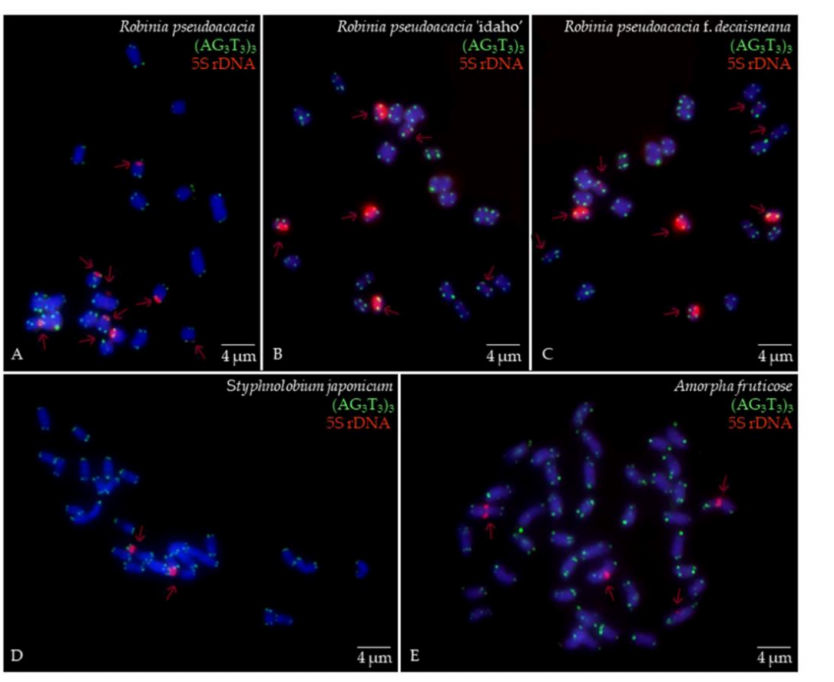
Figure 1. Mitotic metaphase chromosomes fluorescence in situ hybridization (FISH) visualization of R. pseudoacacia ( A ), R. pseudoacacia ‘idaho’ ( B ), R. pseudoacacia f. decaisneana ( C ), S. japonicum ( D ) and A. fruticosa ( E ). The (AG 3 T 3 ) 3 was labelled with 6-carboxyfluorescein (FAM) (green), the 5S rDNA